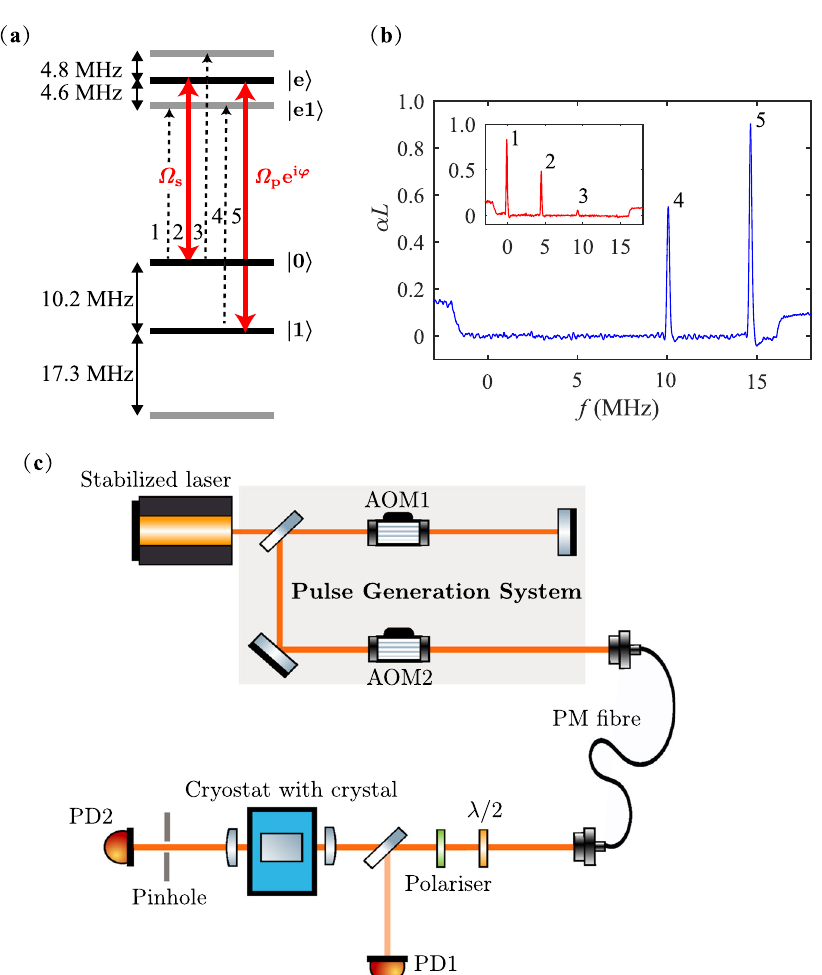
Fig. 1 Relevant energy levels and the experimental setup. a The qubit is represented by ground-state levels |0 〉 and |1 〉 . They are coupled through optical transitions |0 〉 ↔ |e 〉 (Rabi frequency Ω s ) and |1 〉 ↔ |e 〉 (Rabi frequency Ω p ). φ is an arbitrary time-independent phase factor applied to Ω p . The fi ve transitions relevant for measuring the population in the qubit levels are labeled as 1 – 5. b A qubit is initiated at level |1 〉 in a transparent spectral window that has a frequency width of 18.3 MHz. This window covers the frequencies of transitions 1 – 5 shown in a , where the frequency of transition 1 is de fi ned as zero frequency and α L refers to the optical depth. Peaks 4 and 5, located at 10.2 MHz and 14.8 MHz, represents transition 4 and transition 5, respectively. Peak 1 – 3 located at 0, 4.6, and 9.4 MHz represents the transition 1, 2, and 3, respectively, as shown by the inset. Each transition has an inhomogeneous FWHM linewidth of 170 kHz. c The schematic experimental setup. AOM1 (AOM2): the 1st (2nd) acousto-optical modulator. PM fi bre: a polarization-maintaining fi ber, PD1 (PD2): photodetector1 (photodetector2). More information can be seen in “ Methods ” (Experimental